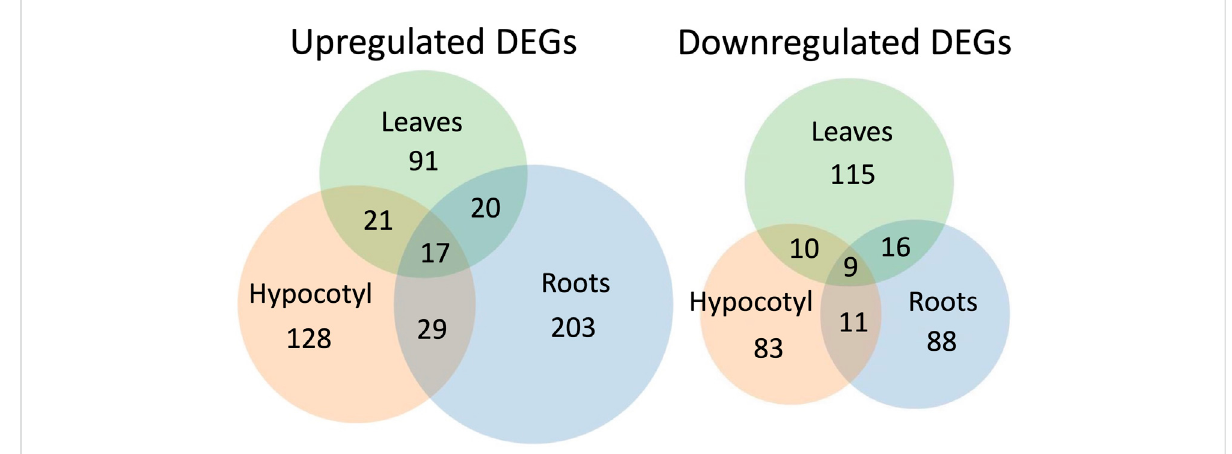
FIGURE 4 VenndiagramsproportionallydepictingtheDEGsidenti fi edindifferenttissues.Modi fi edfromPauletal.(2013).Thesedataweregeneratedfrom samples of different wildtype lines. 40% of the tissue analyzed was collected from WS plants, and the remaining 60% was taken from COL